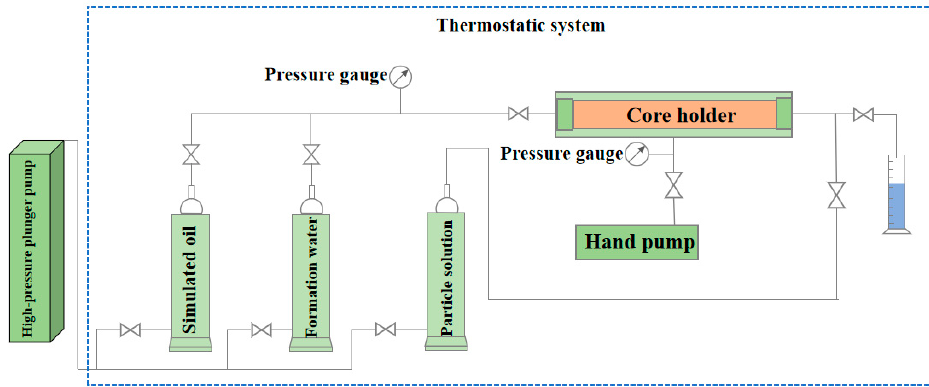
Figure 1. Particulated core flow test apparatus.